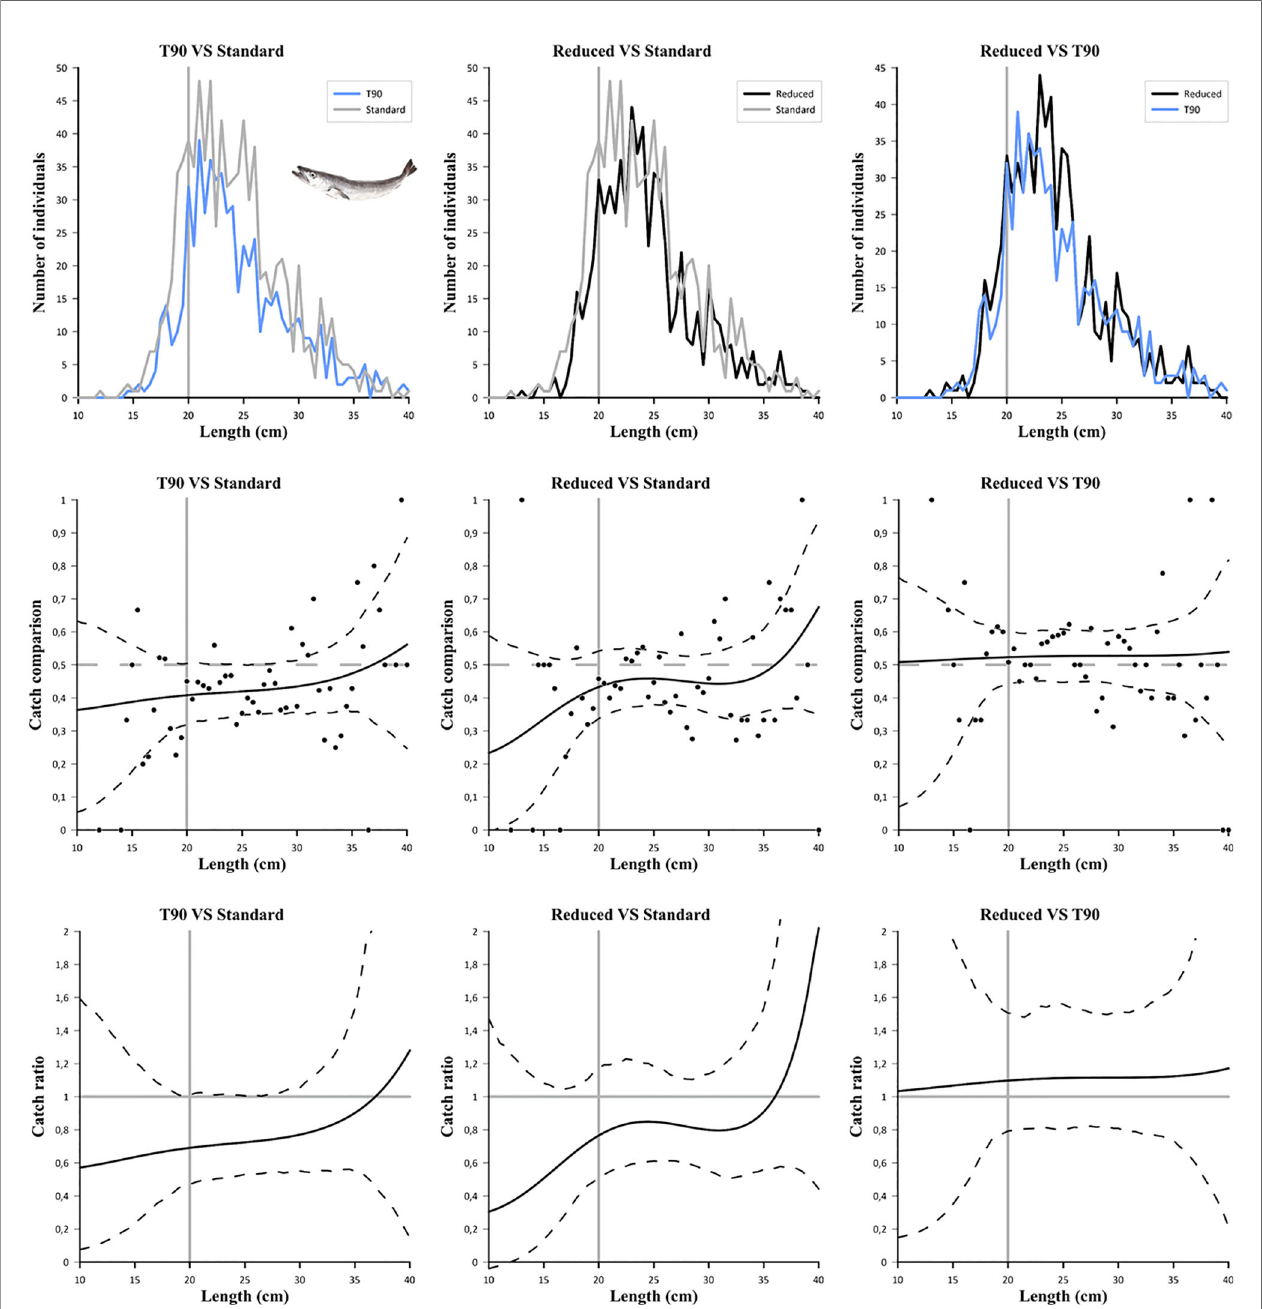
FIGURE 3 | Upper graph: Length frequency distribution of European hakes caught by the con fi gurations tested (Standard, Reduced and T90). Middle graph represents the modelled catch comparison rate, and lower graph the catch ratio (black line). Black circles represent the experimental rate, and the black stippled curves represent 95% CIs . The grey horizontal line at 0.5 and 1.0 represents the point at which both con fi gurations have equal catch rates. The grey vertical line represents the MCRS for